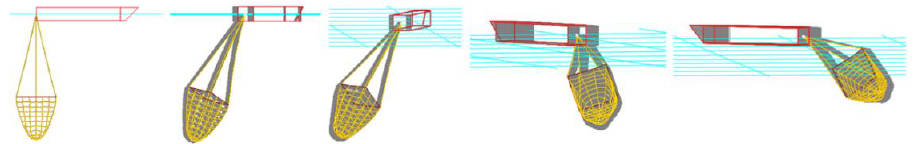
4 m/s. v = 4 m/s. 4 m/s. 4 m/s.